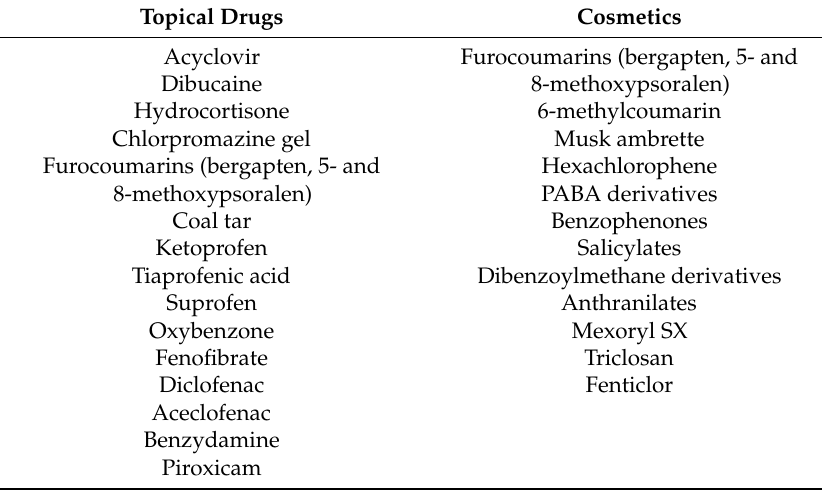
Table 3. Topical drugs and cosmetics discussed / cited in the